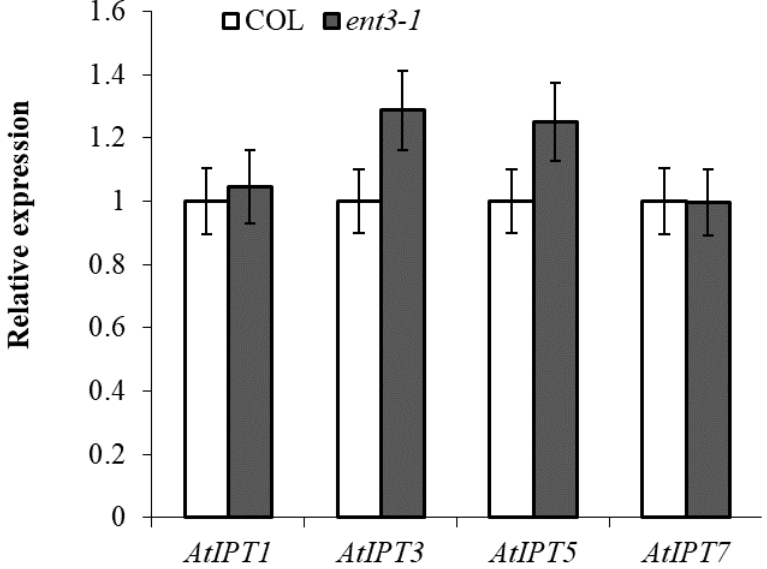
Figure 2. Level of transcripts of IPT1 (AT1G68460.1) , IPT3 (AT3G63110.1) , IPT5 (AT5G19040.1), and